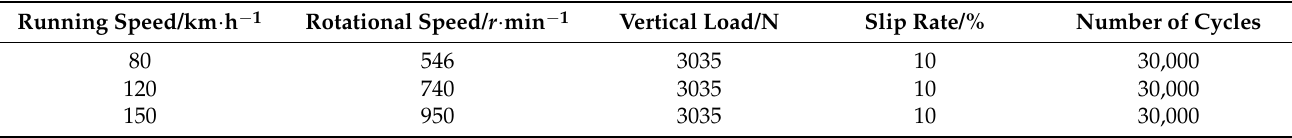
Table 4. Test parameters and calculation results of contact